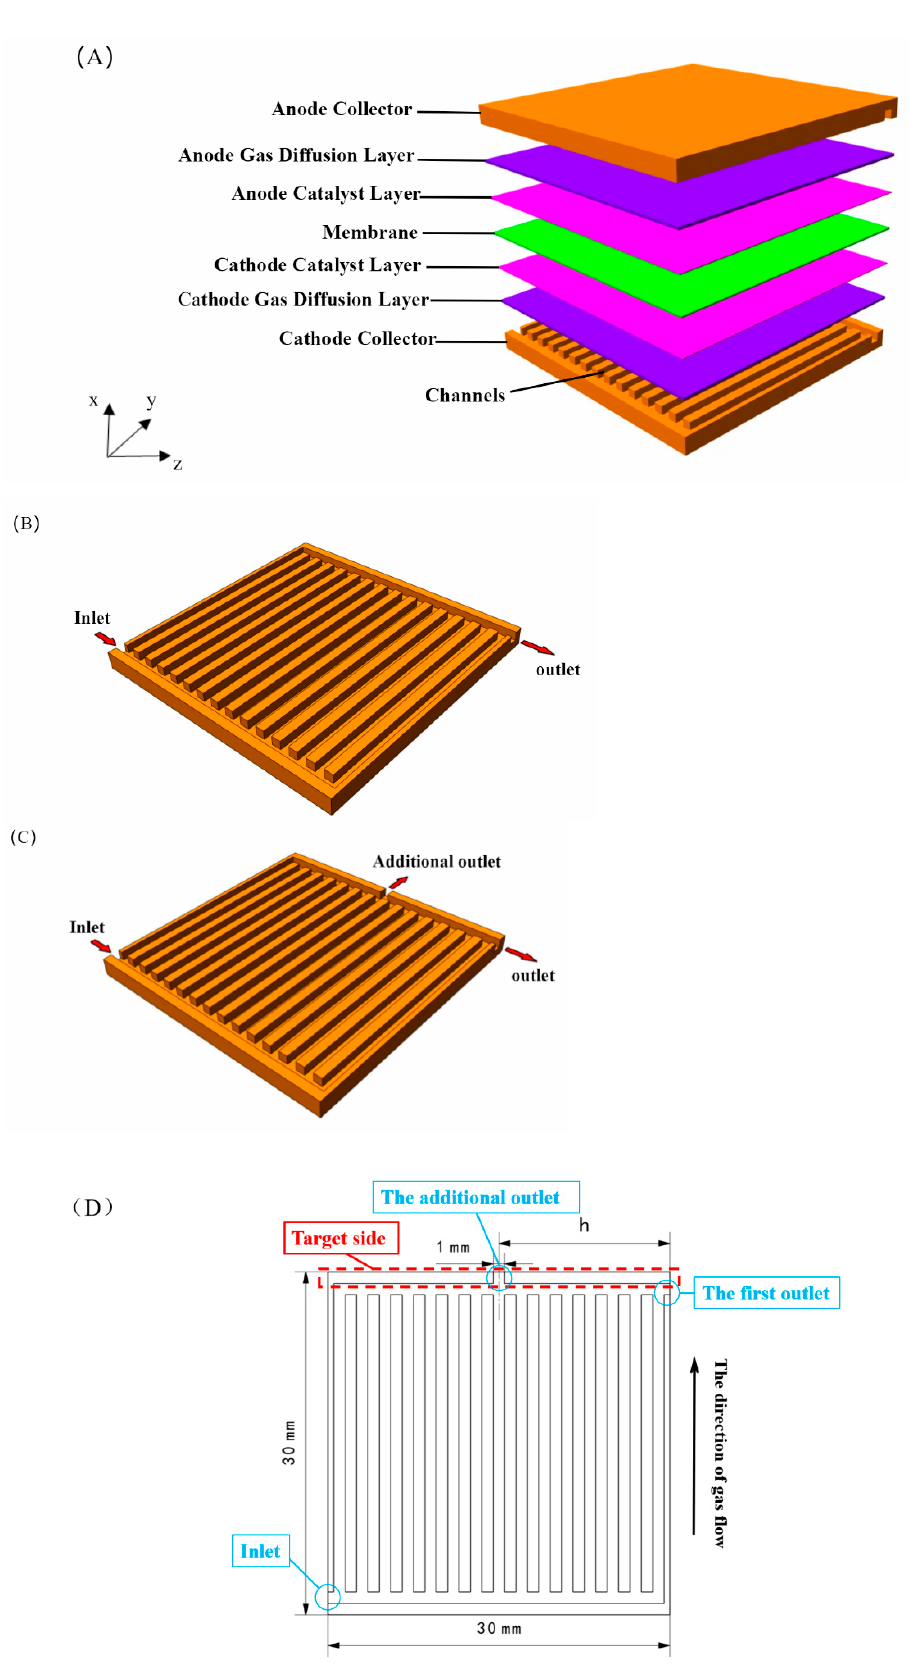
Figure 1. Schematics of ( A ) PEMFC, ( B ) the conventional outlet pattern, ( C , D ) the additional outlet pattern at the flow field plate.